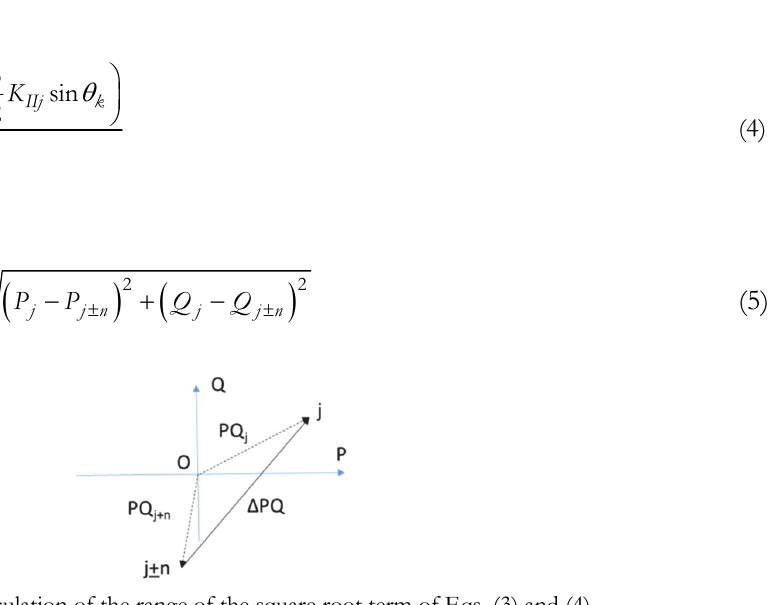
Figure 4: Calculation of the range of the square root term of Eqs. (3) and